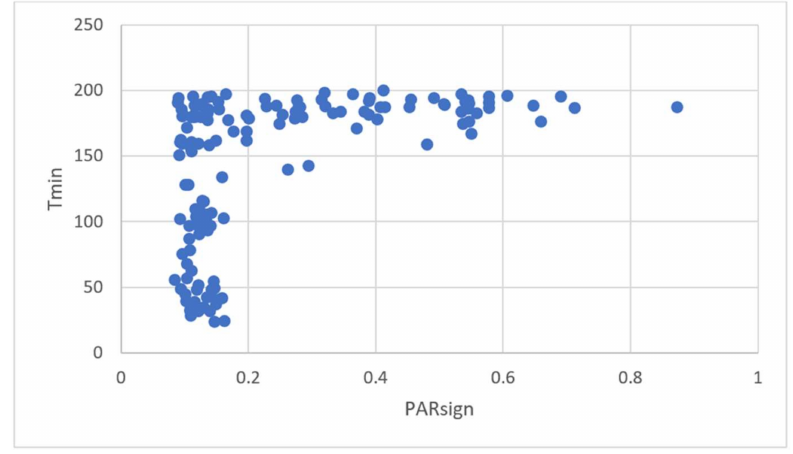
Figure 5. Determination of the parameter PARsign, where the accepted value is